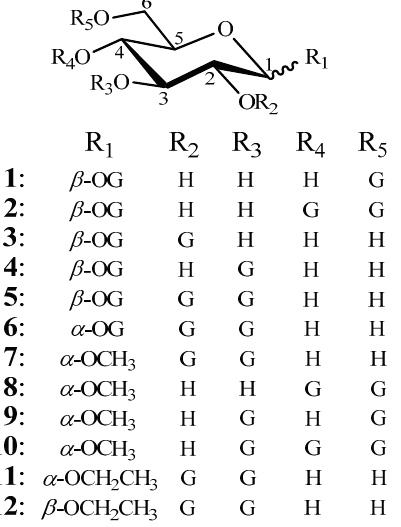
Figure 1. Chemical structures of twelve galloyl glucosides 1 – 12